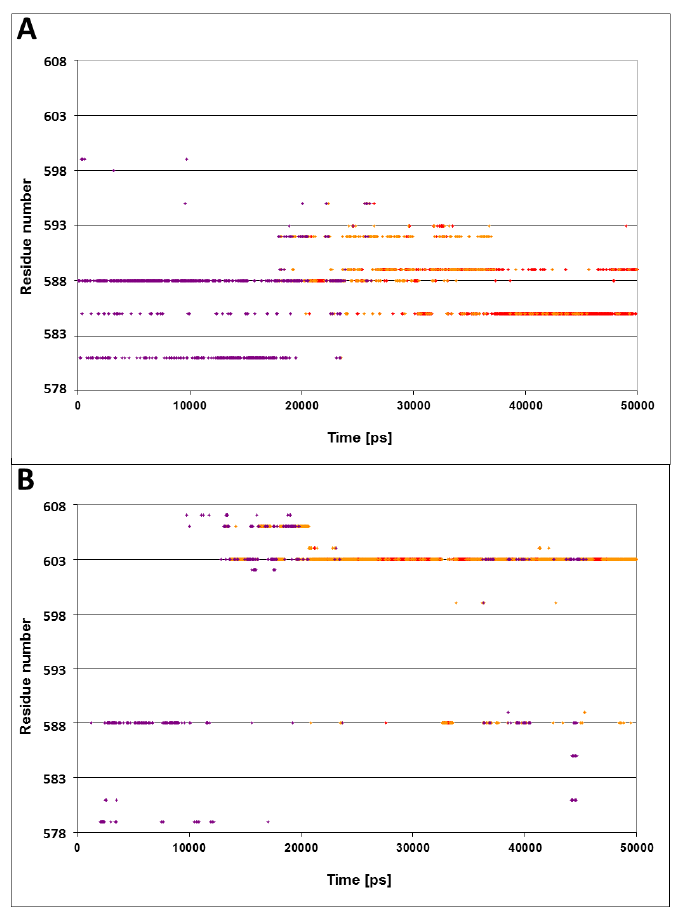
Figure 4. The effect of the peptide’s charge on the proximity to the residues of the lid. The dots describe the spatiotemporal analysis of the simulations of the complexes with either N1R mutation (double charged) of the peptide (panel A ) or the uncharged mutated peptide R2A (panel B ). The color code for the distances is as in Figure